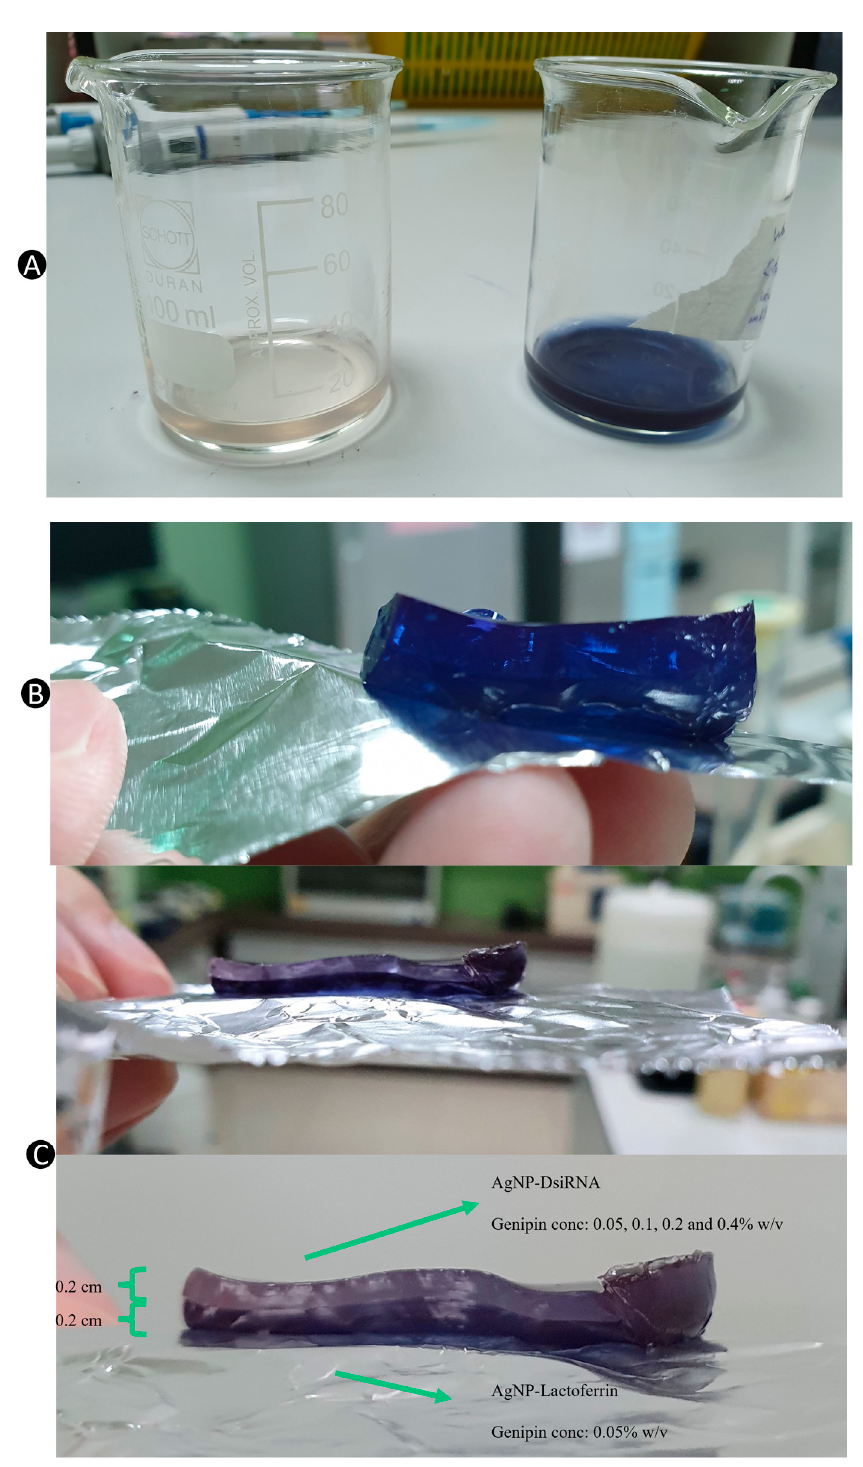
Figure 5. ( A ) Formation of hydrogel indicated by the color change, ( B ) Cross-sectional view of the formed SL hydrogel, and ( C ) Cross-sectional view of the formed DL hydrogel.